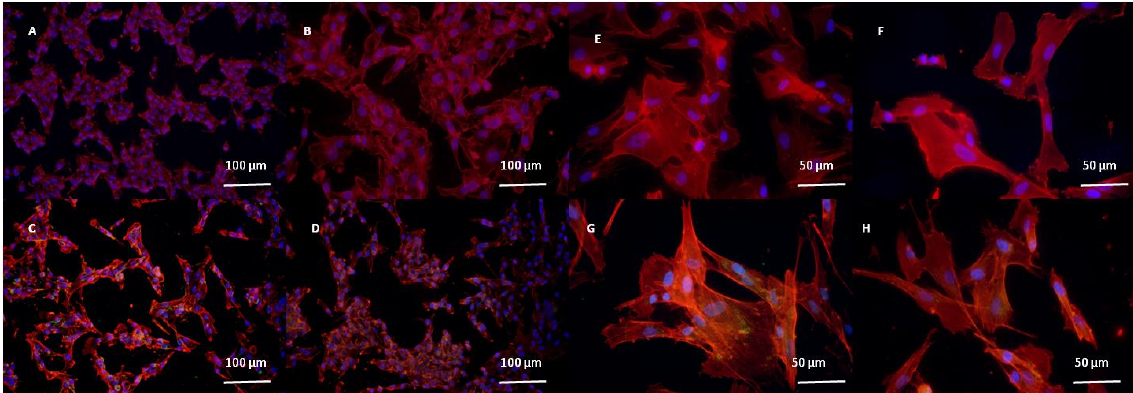
Figure 12. Fluorescence microscopy images of cells at 5 days of culture after the presence/absence of nanoparticles for 16 h: ( A , E ) control B16 cells and respectively BJ cells (0 nanoparticles), ( B , F ) B16 cells and respectively BJ cells exposed to 62.5 µg/mL SBA-15, ( C , G ) B16 cells and, respectively, BJ cells exposed to 62.5 µg/mL to SBA-NBDH, ( D , H ) B16 cells and, respectively, BJ cells exposed to 62.5 µg/mL SBA-NBD-PD. Red: Texas Red Phalloidin, blue: Hoechst, green: benzofurazan derivatives autofluorescence (NBDH and NBD-PD).